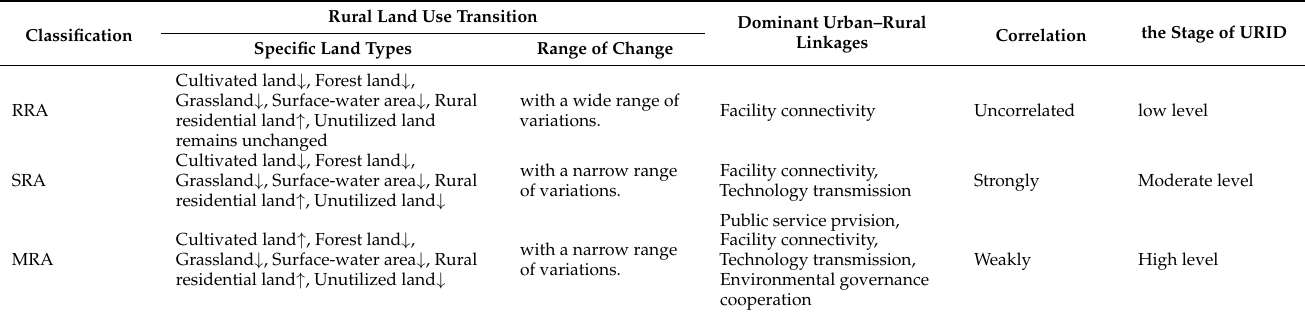
Table 4. Corresponding relationship between rural land use transition and